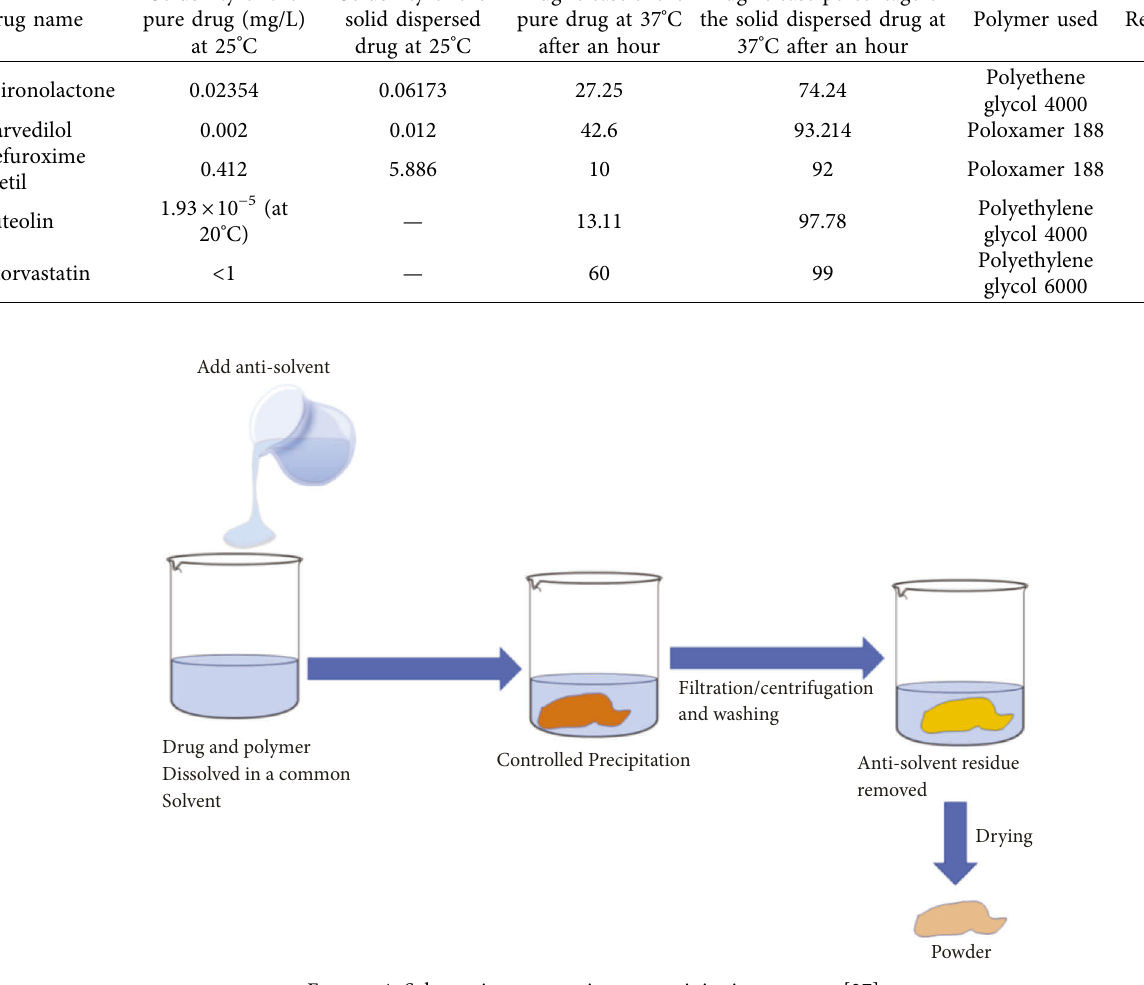
Figure 4: Schematic presentation coprecipitation process